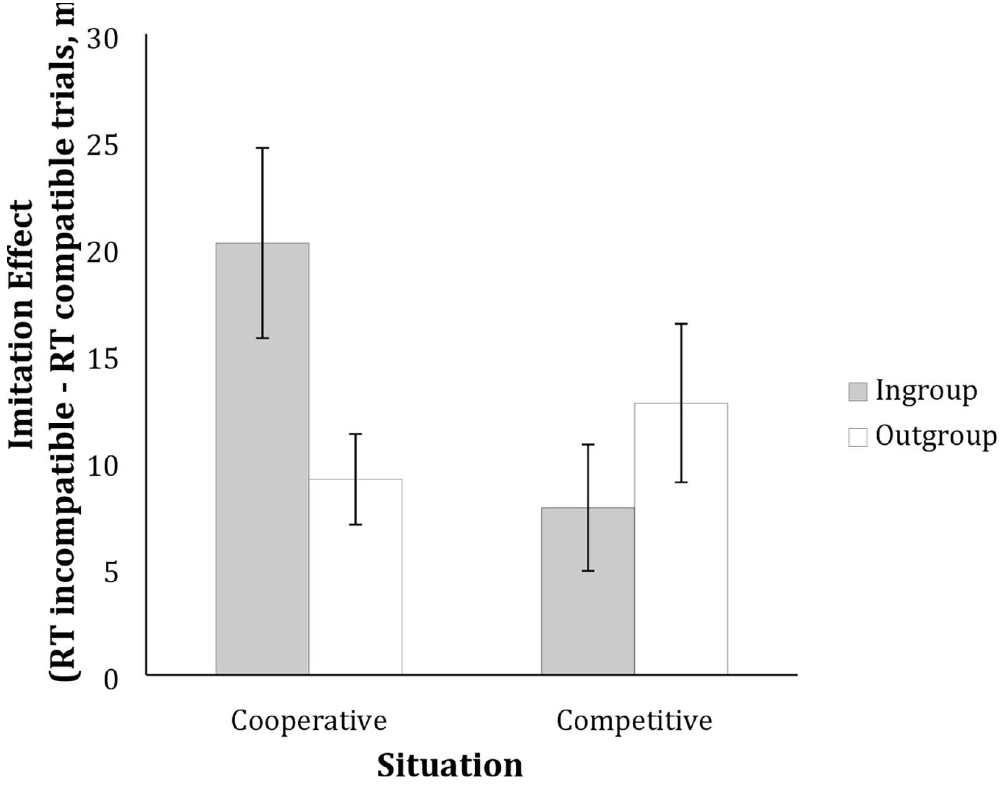
Fig 3. Mean ± standard error of the mean imitation effect in the four